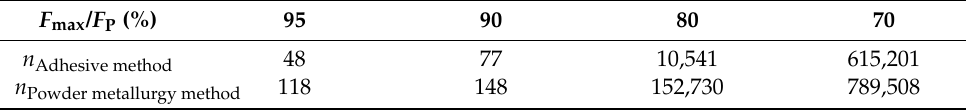
Table 3. Fatigue life of AFSs made by different preparation